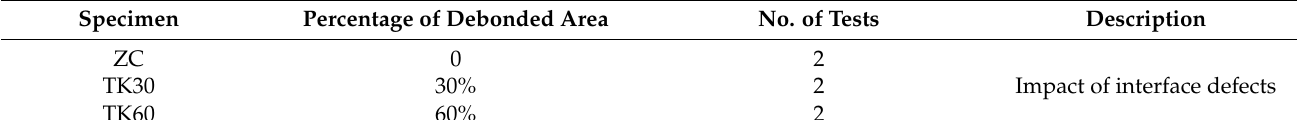
Table 1. Grouping of push-out test specimens.